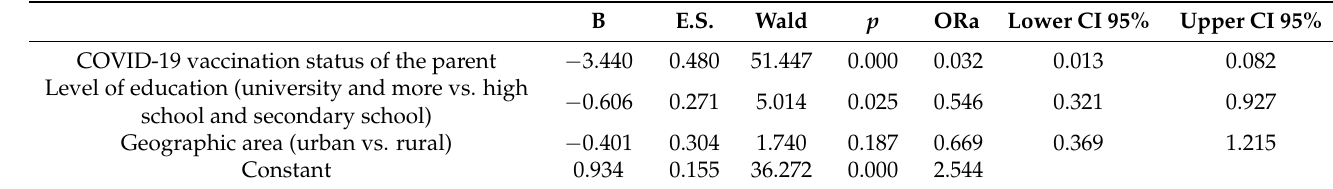
Table 3. Logistic regression model for COVID-19 vaccination of children aged between 12 and 18 years.